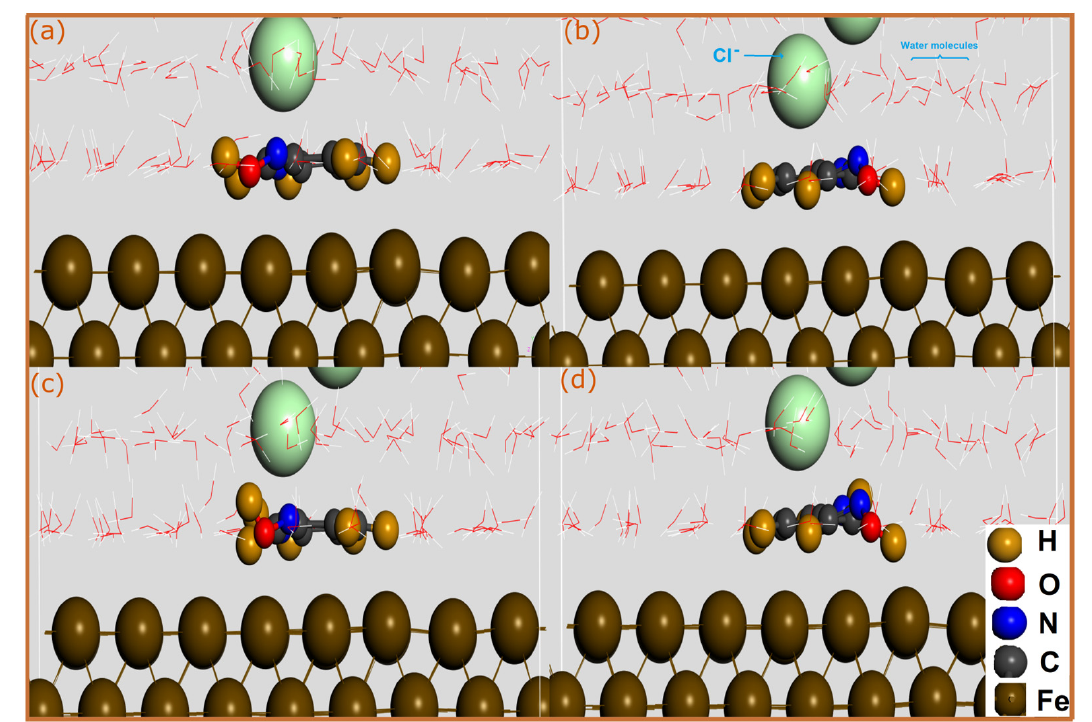
Figure 5. The most stable adsorption configurations of pyridine molecules adsorbed on Fe(110) sur- face in aqueous phase obtained by MD simulations; ( a ) 2POH, ( b ) 3POH, ( c ) 2POH + and ( d ) 3POH + .